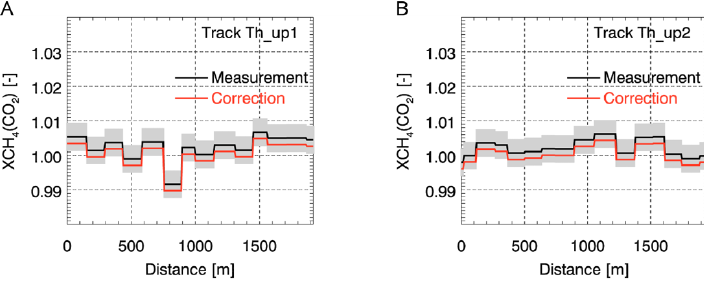
Fig. 13. Measurements along horizontal cross sections upwind of Theodor Shaft (black). Additionally the 1 σ uncertainty range based on the precision (grey) and a topography correction is shown (red). See Fig. 12 for position of the cross